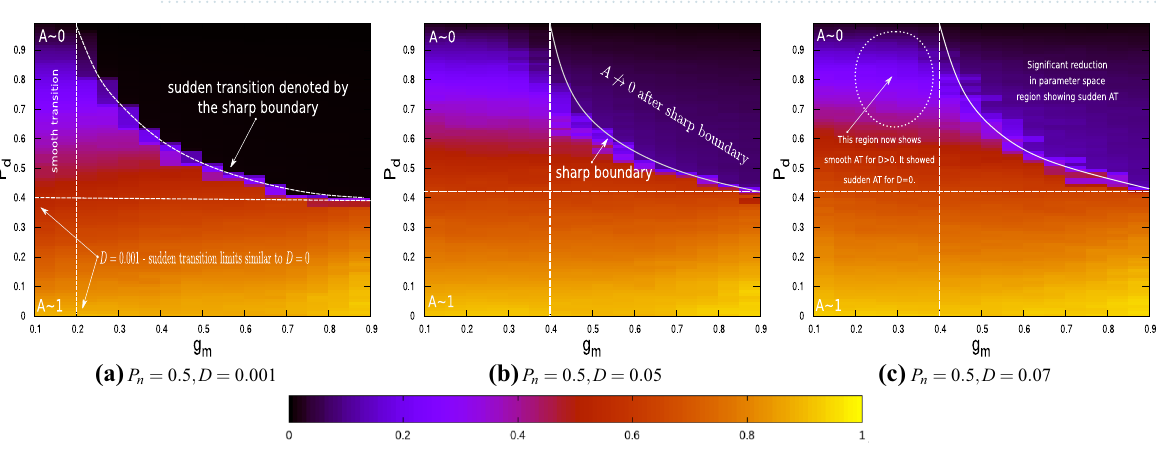
Figure 8. The order parameter A plotted as a function of P d and g m for P n = 0.5 and ( a ) D = 0.001 , ( b ) D = 0.05 and ( c ) D = 0.07 . The dark/black coloured region shows where A → 0 whereas yellow shows where A → 1 . The colour-map which is common for all three figures is shown below the